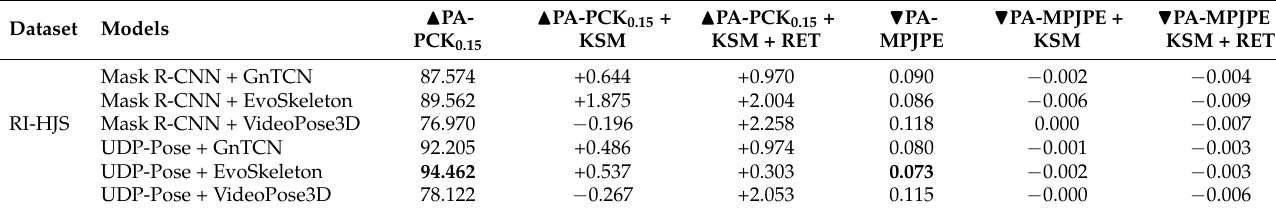
Table 5. Results of model combinations for 3D pose estimations on the custom dataset of players performing handball jump-shot (RI-HJS). The best results are marked in bold. Models Mask R-CNN and UDP-Pose were trained on 227 images from the RI-HJS dataset, while evaluation was performed on the rest of the dataset. Metrics are computed on the normalized poses using the h-norm described in Sections 2.5 and 2.6 on 13 keypoints. KSM in the table is shorthand for Kalman smoother that is applied on the predicted sequence before evaluation, while KSM + RET is shorthand for Kalman smoother applied on the predicted sequence and Retargeting applied both on predicted and ground truth sequences.